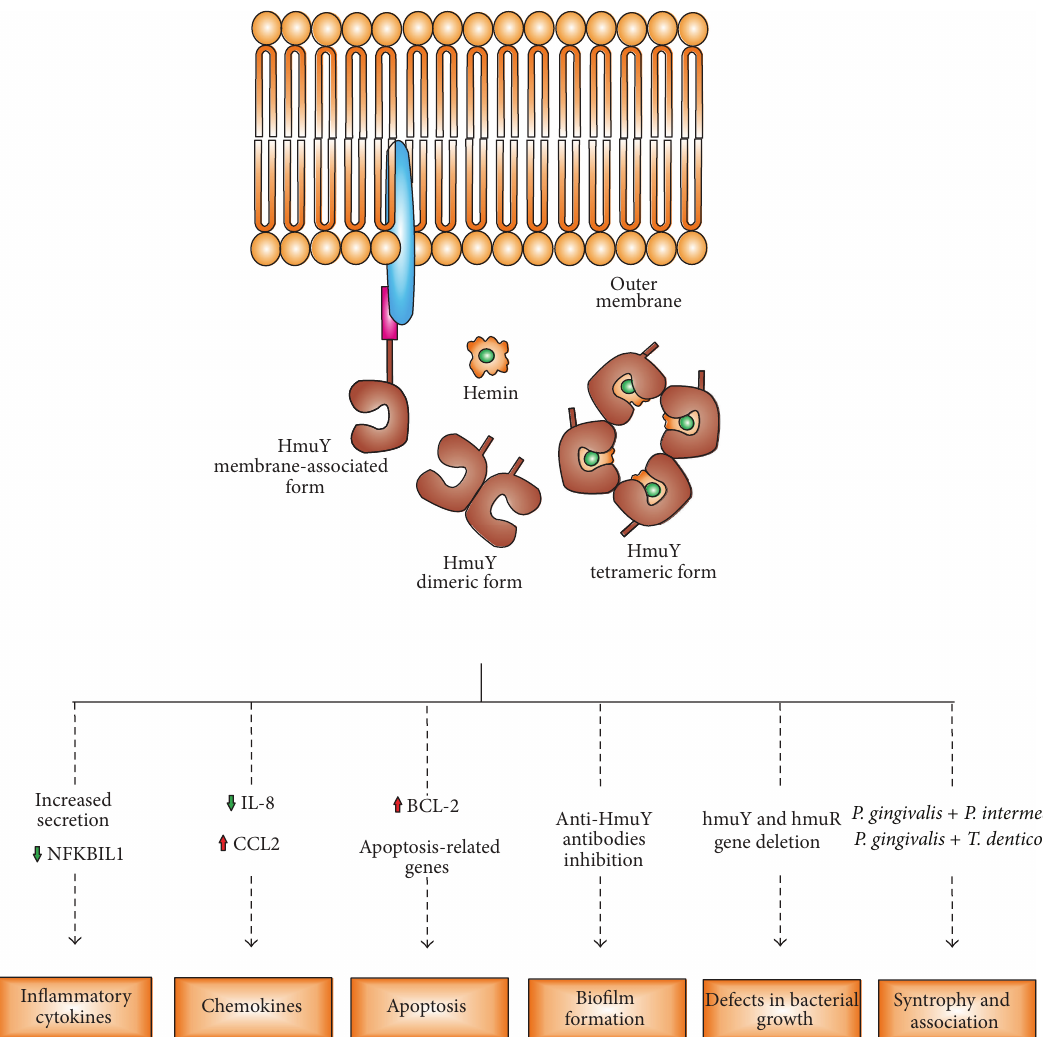
Figure 1: Schematic presentation of role of P. gingivalis HmuY in immunopathogenesis of chronic